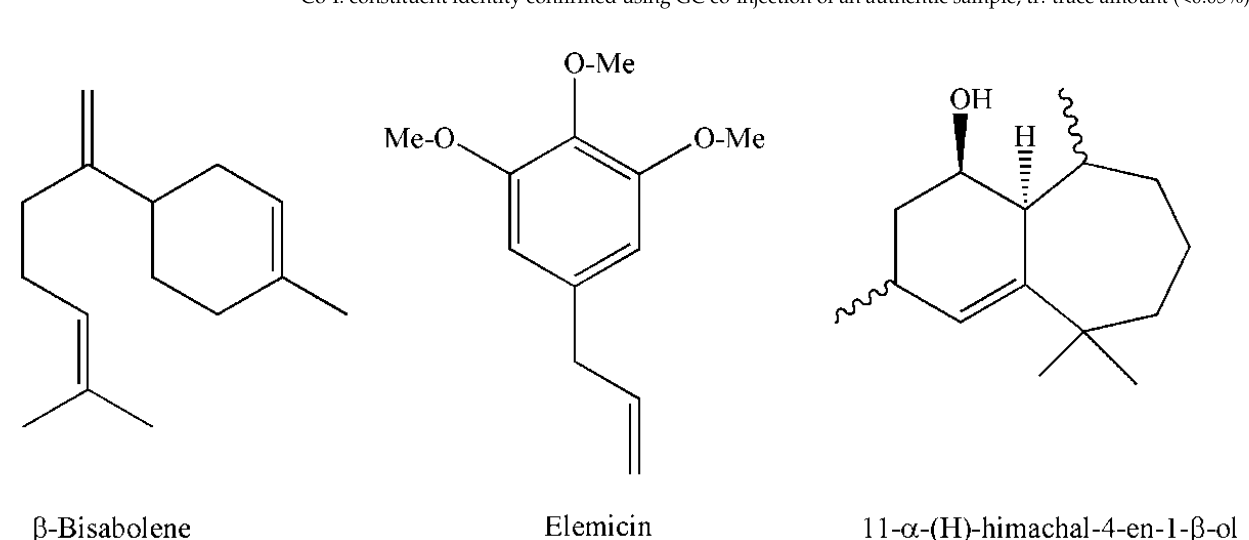
Figure 3. S tructures of the most abundant components in wild carrot umbels. Figure 3. Structures of the most abundant components in wild carrot components were identified, mainly (54.7%), oxygenated sesquiterpenes (22.1%), phenylpropanoids (18.7%), monoterpene hydrocarbons (2.8%), and oxygenated monoterpenes (1.5%), representing 99.8% of the total essential oil composition from mature–fully ripening wild carrot umbels (Table 1).